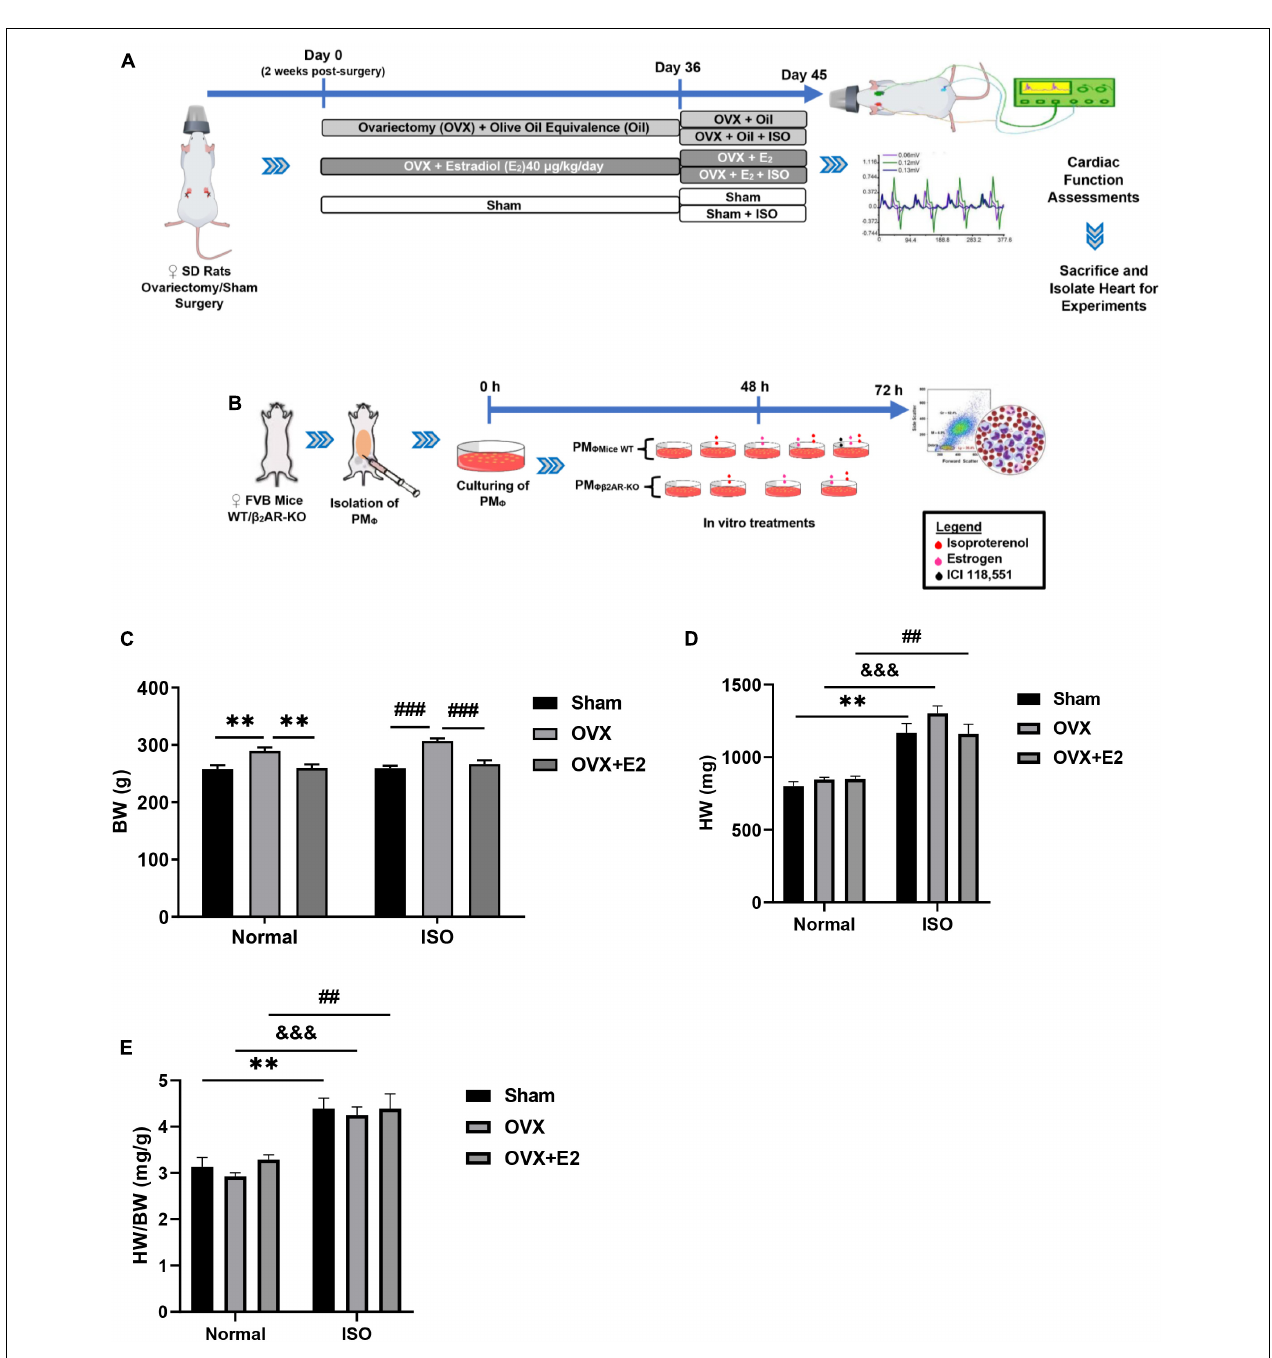
FIGURE 1 | (A,B) Illustration of the experiment timeline for making in vivo and in vitro models, respectively. (C–E) Graphical presentations of morphometric data demonstrate alterations in body weight (BW), heart weight (HW), and HW/BW coefficient during chronic stress and estrogen deficiency ( n = 8 rats/group). ∗∗ p < 0.01; ## p < 0.01 and ### p < 0.001; $$$ p < 0.001. Data are presented as mean ± SEM. Data were analyzed using two-way ANOVA, followed by Sidak’s post hoc analysis.